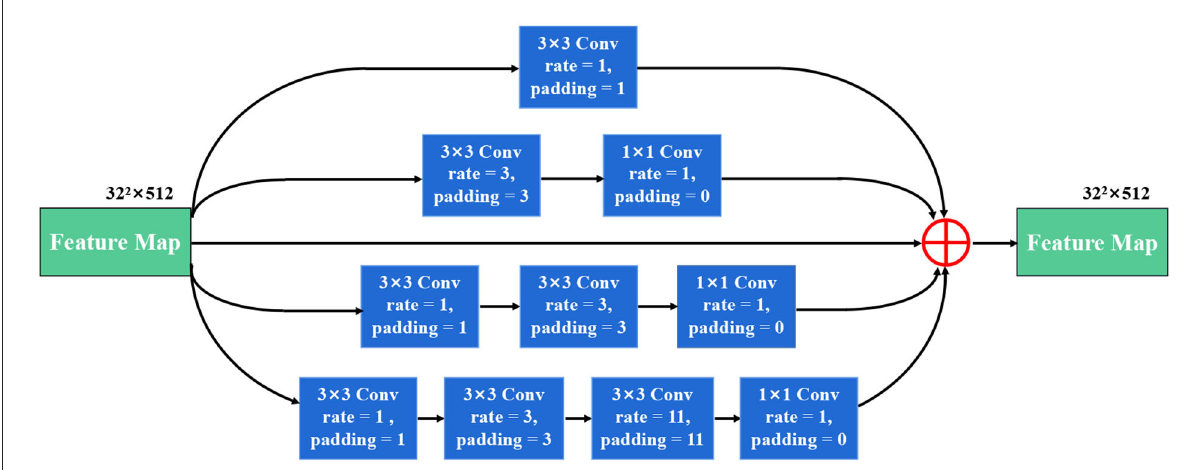
FIGURE4 The illustration of the stackable dilated convolution (SDC) block. It has four branches of dilated convolution stack: 3x3 convolutional layer. Each branch is stacked with dilated convolutions with expansion rates of 1, 3, and 11. The SDC block can extract features from different